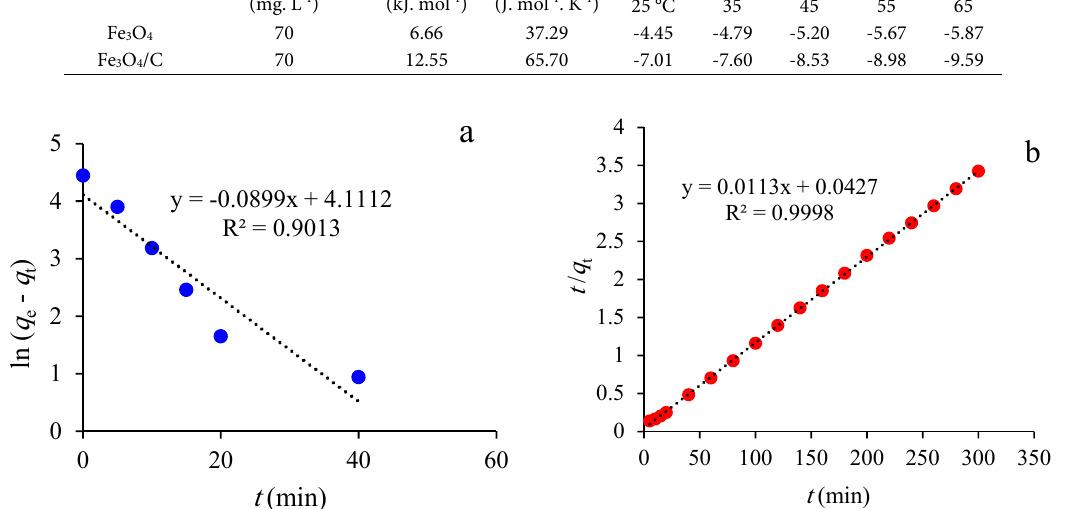
Fig. 16: Pseudo-first-order (a) and pseudo-second-order (b) MB adsorption plots on Fe